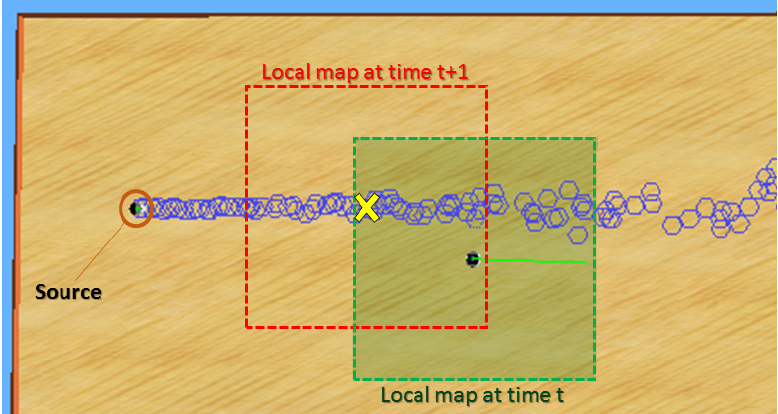
Figure 3. At time t , the local mp is located at the position of the green square. The yellow cross shows the maximum a posteriori value of the posterior probability density function, which is the point that is going to become the center of the local map at time t + 1. When the robot decides to move the map, it travels to the yellow cross point, and it restarts the procedure in the local map indicated by the red